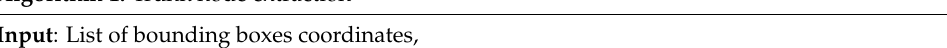
Algorithm 1. Trunk node extraction